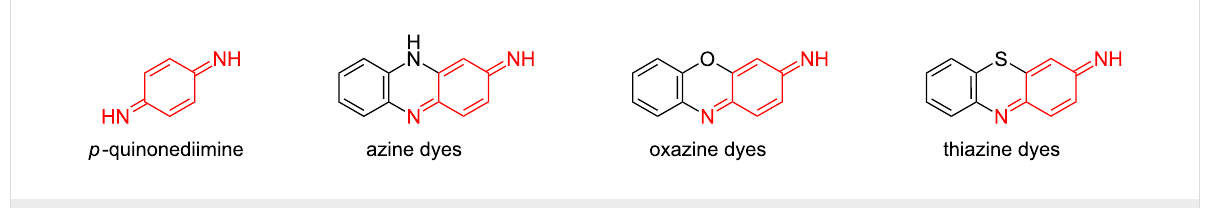
Figure 1: Quinone imine structural relationships.